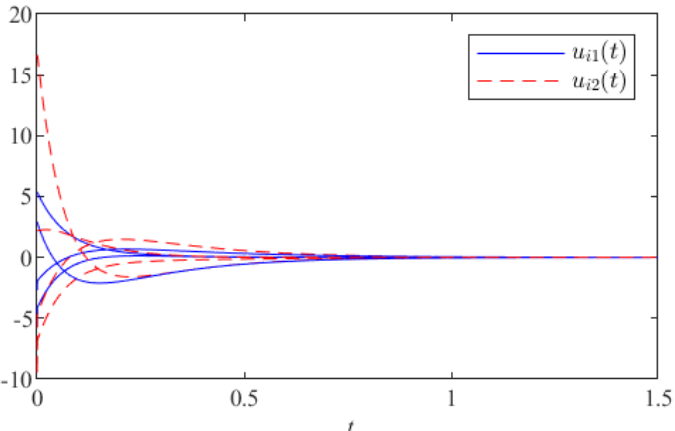
Figure 7. The boundary coupling u i ( t ) in Example 2.